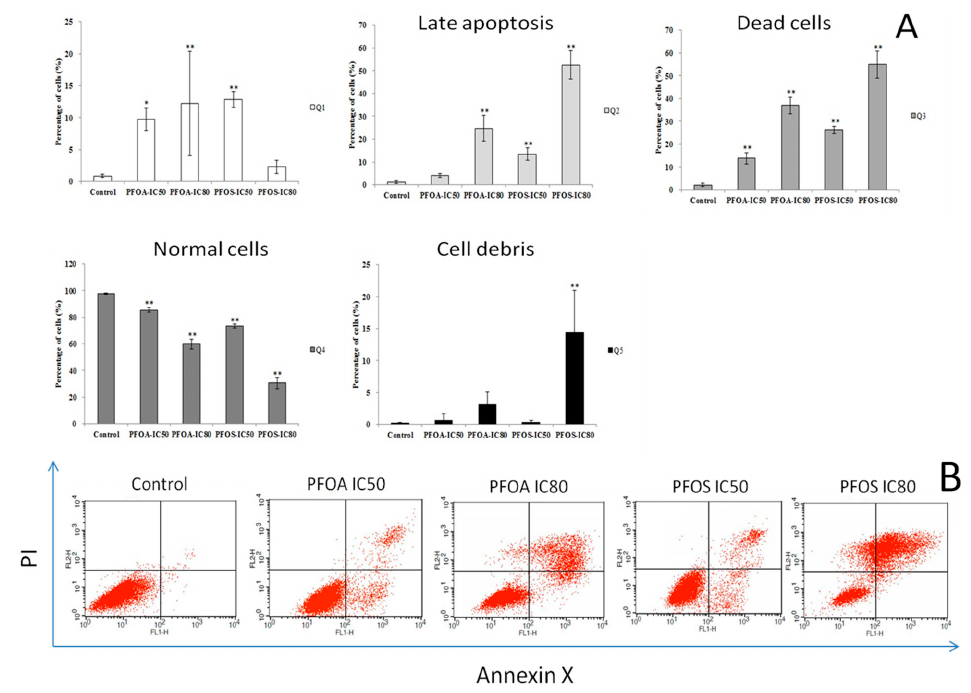
Figure 3. Detection of apoptosis on ZFL cells exposed to PFOA and PFOS using flow cytometry. ZFL cells were treated with PFOA or PFOS at IC 50 or IC 80 concentrations for 48 h. Annexin V-FITC-PI kit was used for detecting cell apoptosis by flow cytometry. Percentage of cell apoptosis after treatment with PFOA or PFOS in three independent experiments. * p < 0.05, ** p < 0.01.